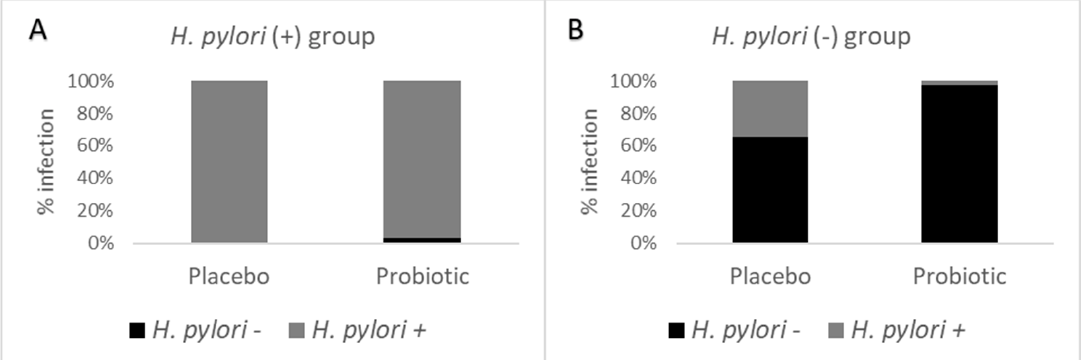
Figure 3. Effect of consuming the probiotic gelatin (100 g serving) containing 10 7 CFU mL − 1 L. fermentum UCO-979C strain (in 100 g serving) for 12 weeks on the percentage of H. pylori -infected participants at the end of the intervention. ( A ) H. pylori -infected participants before the intervention; ( B ) H. pylori non-infected participants after the intervention. H. pylori ( − ): H. pylori non-infected participants; H. pylori (+): H. pylori -infected participants.